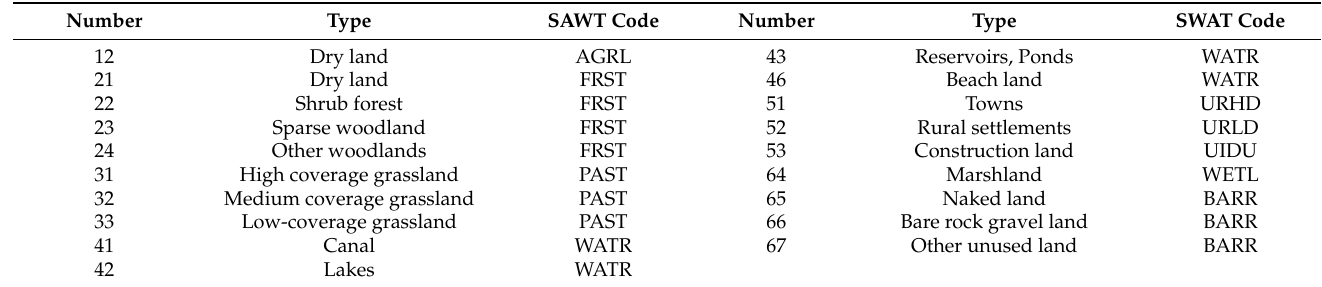
Table 3. The reclassification (to SWAT codes) of land use in upper Taohe River Basin.